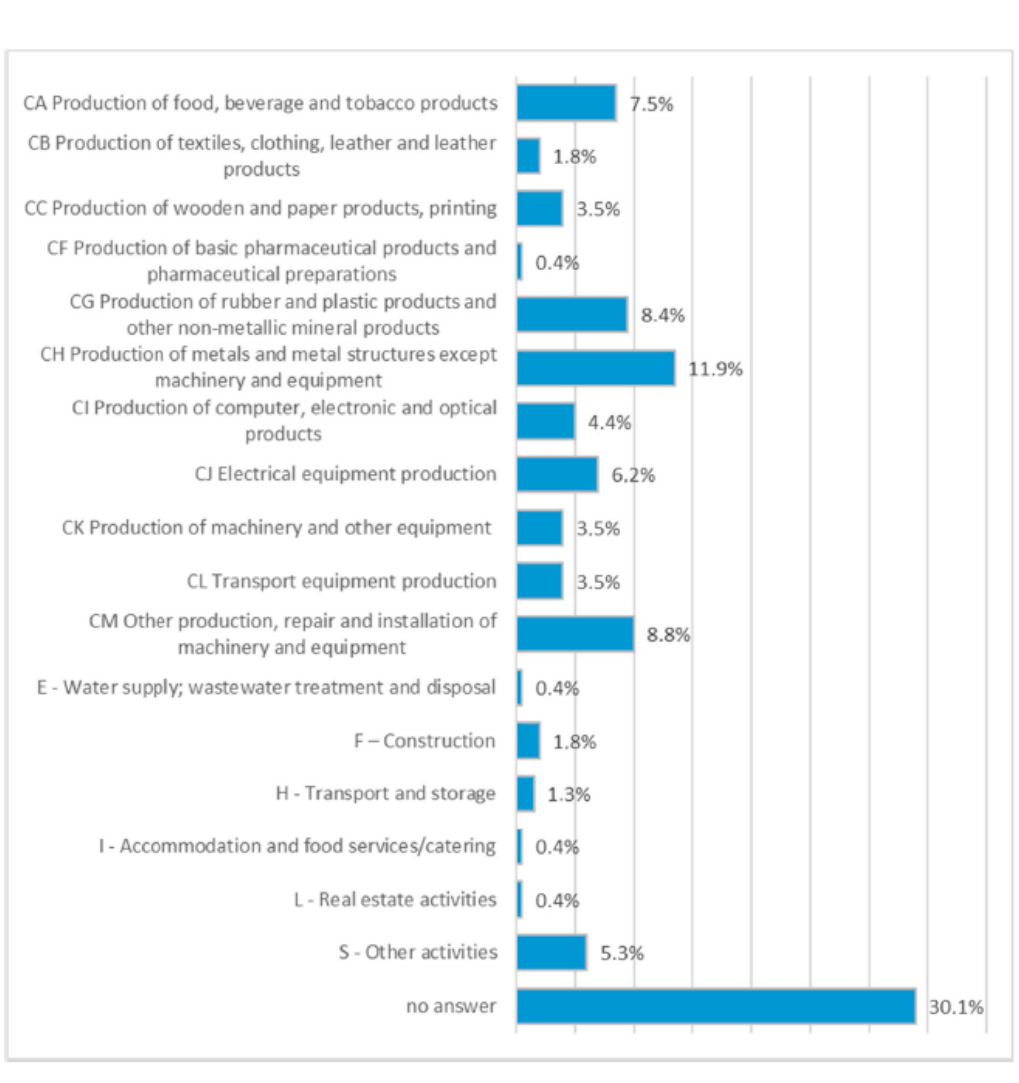
Figure 1. The main area of the company ’ s operation. Table 1. The main area of the company ’ s operation.